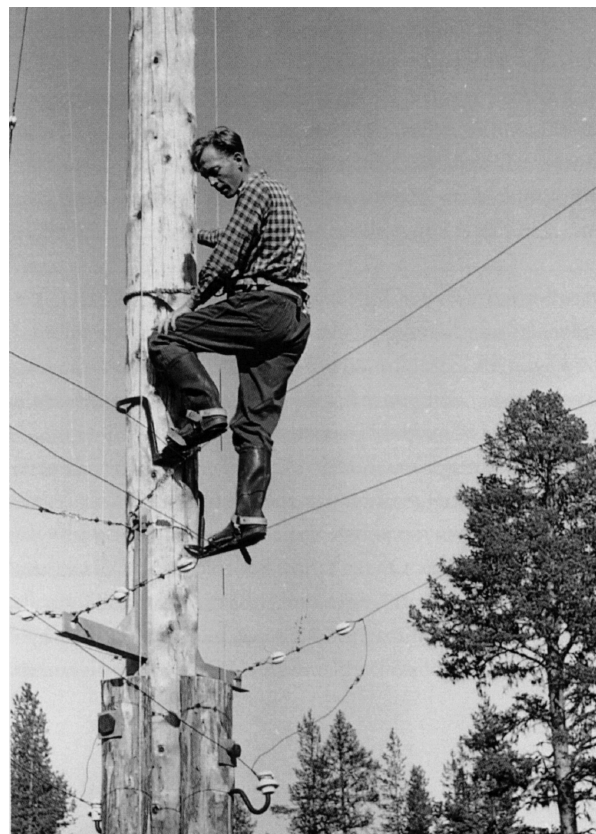
Figure 9. Juhani Oksman climbing up the antenna mast of the iono- spheric station (photo provided by Juhani Oksman).